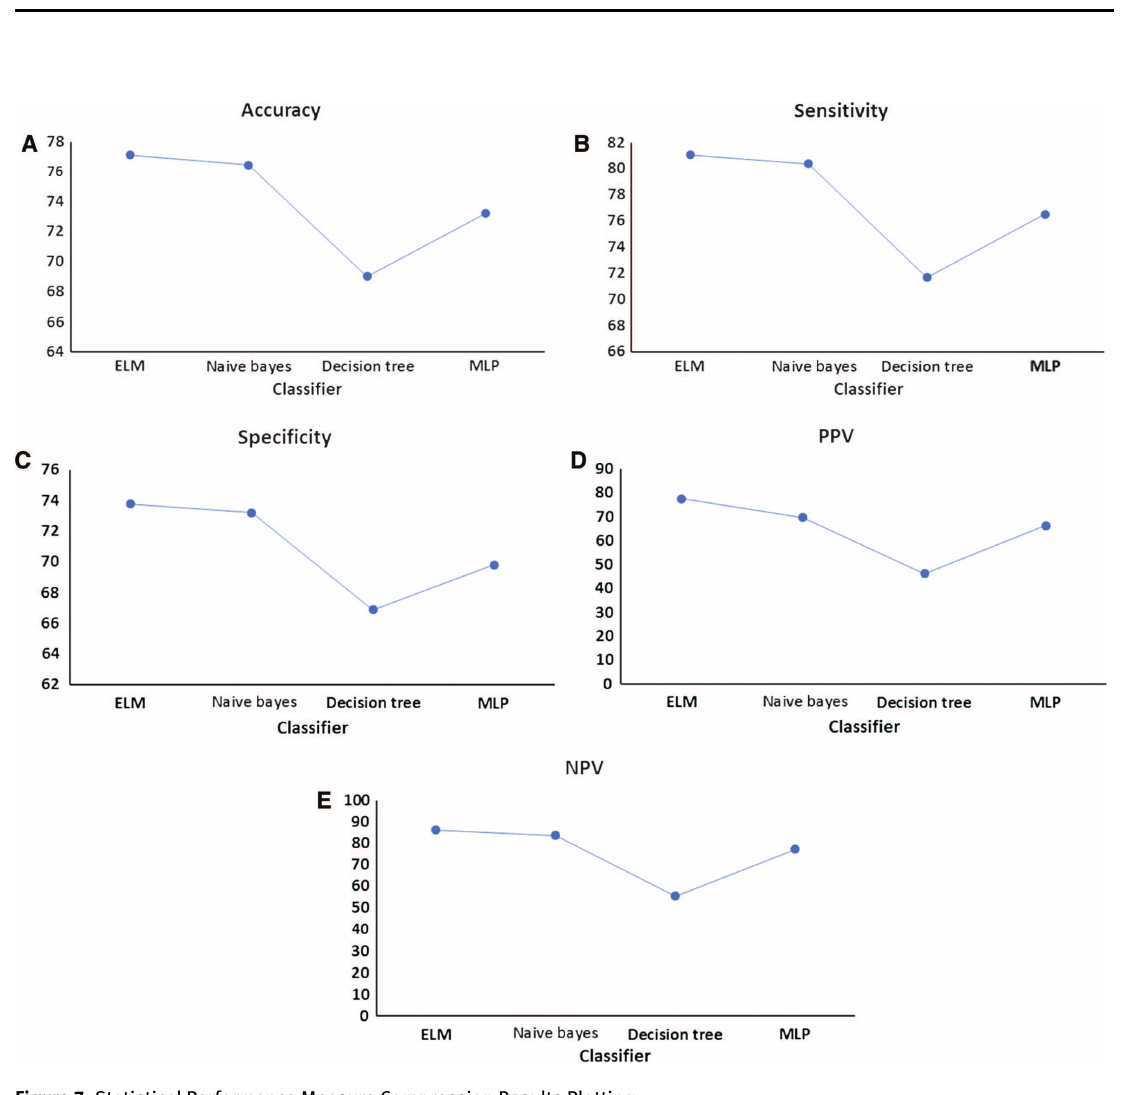
Figure 7: Statistical Performance Measure Compression Results